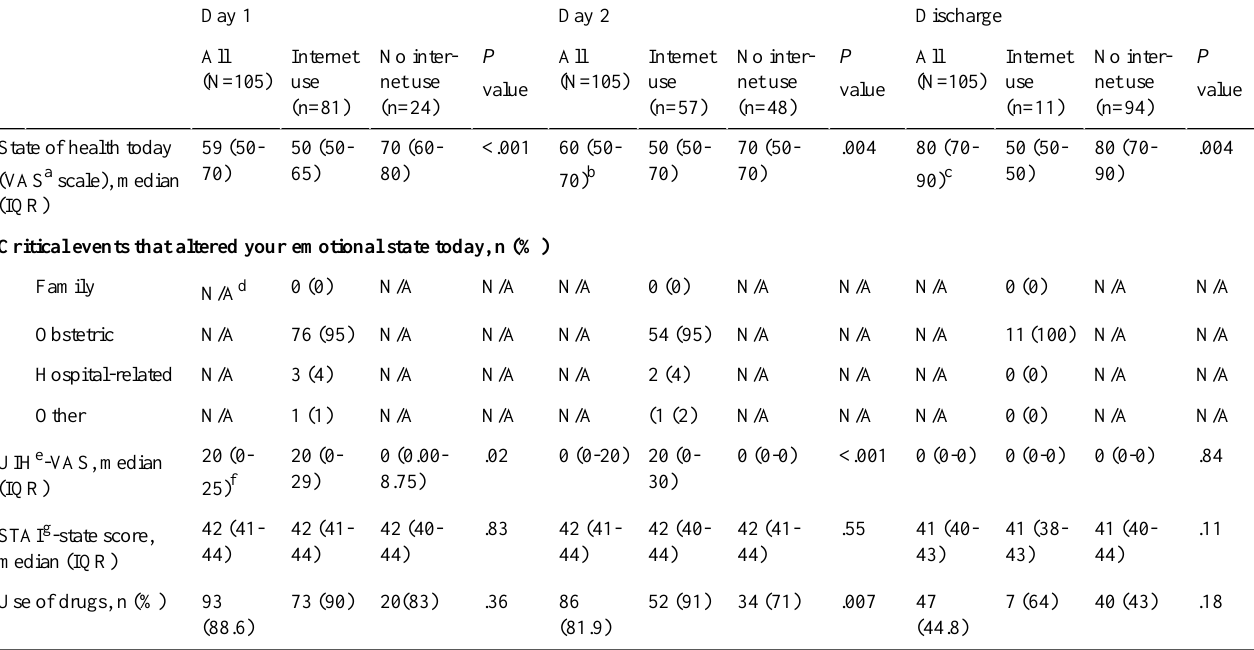
Table 2. Behavior of internet use, health status, critical events, anxiety, and drug use on the first two days of hospitalization and at